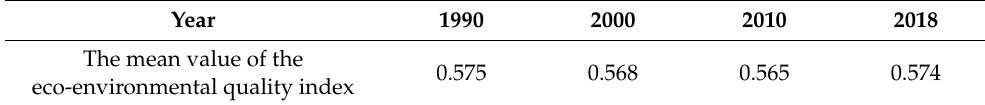
Table 6. Eco-environmental quality index